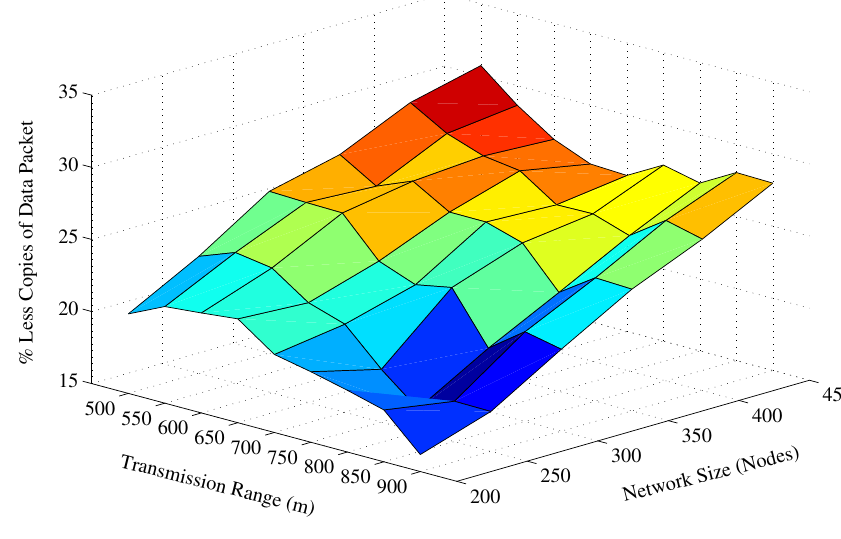
Figure 7. Overall data packet suppression achieved by the proposed scheme for different T r and network